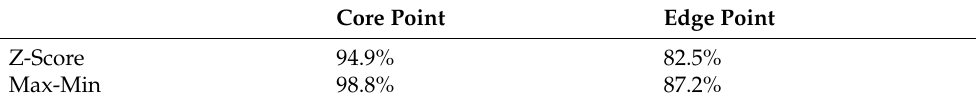
Table 1. Accuracy corresponding to different normalization methods.